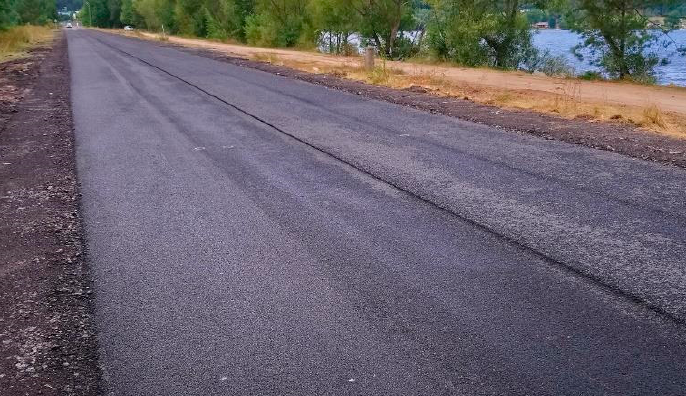
Figure 12. Third, final long test section (K)–Spokojna St., Kartoszyno, September 2020.